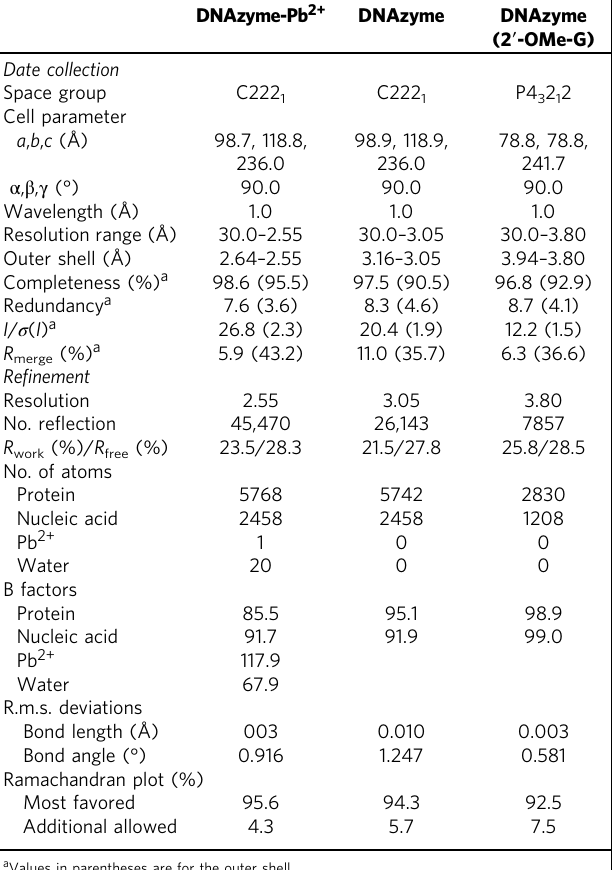
Table 1 Data collection and re fi nement statistics DNAzyme-Pb 2+